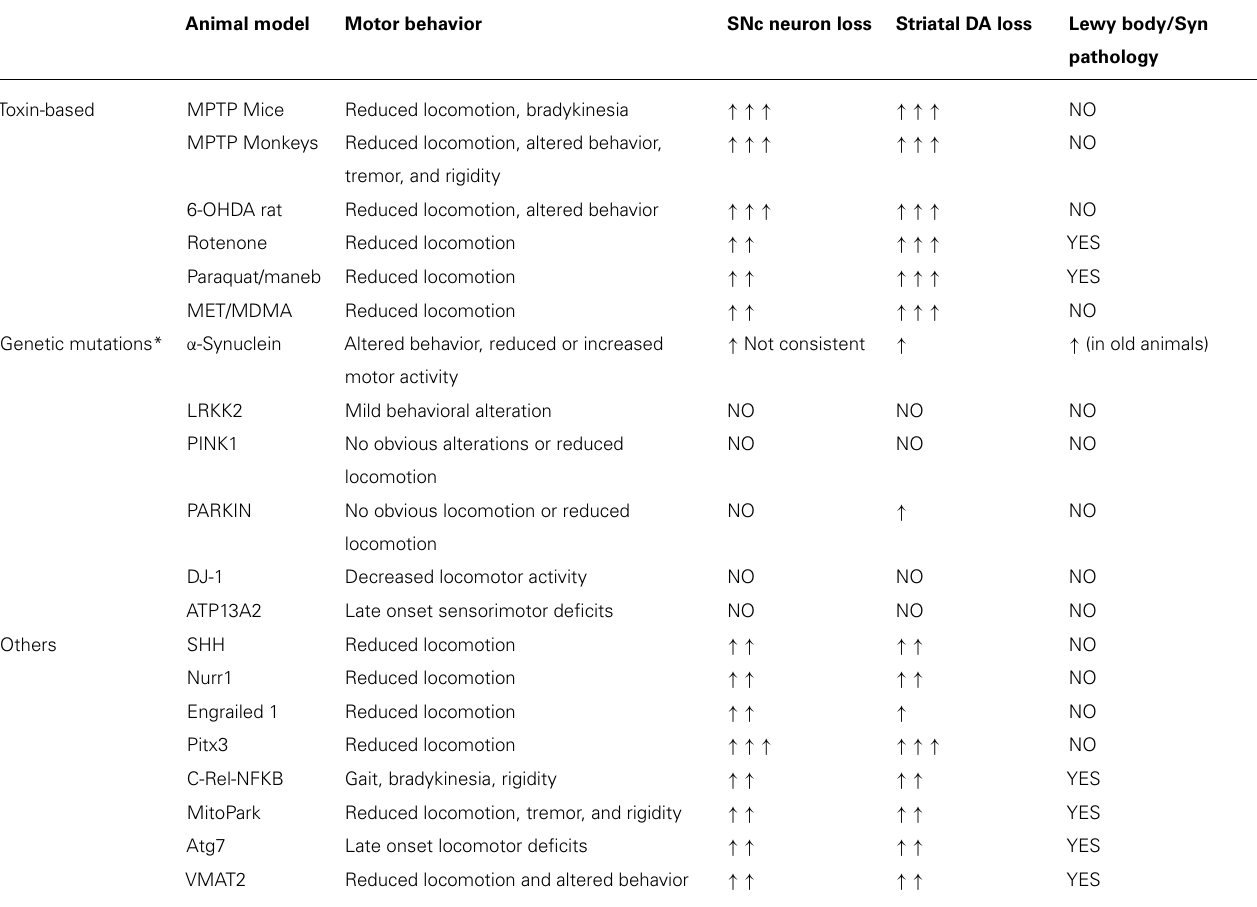
Table 1 |Animal models of Parkinson